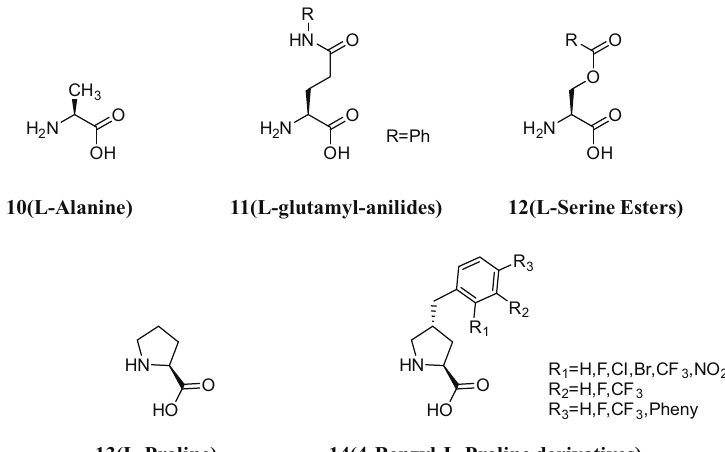
Figure 6: Structures of compounds 10 – 14.